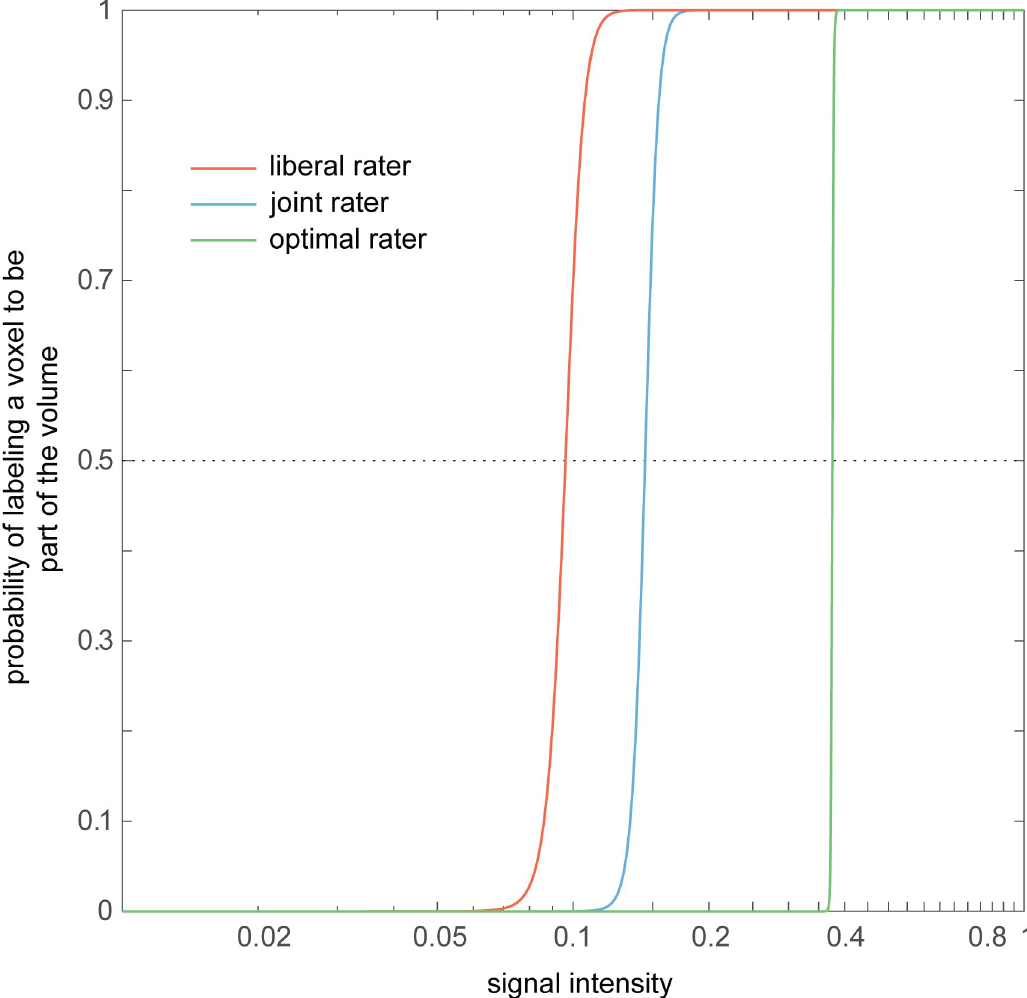
Fig 3. Psychometric curves used to simulate detection-thresholds and sensitivity in labeling procedures. Psychometric curves represent the probability (y-axis) that a voxel will be labeled as part of the ellipsoid given its signal intensity (x-axis). Colors represent the liberal human rater (red), the joint-labeling of two human raters (blue), and as a reference, the (average) optimal rater (green). Values are presented on a logarithmic scale. resolution (0.1 x 0.1 x 0.1mm) and compared the labeled mask with that of an optimal rater